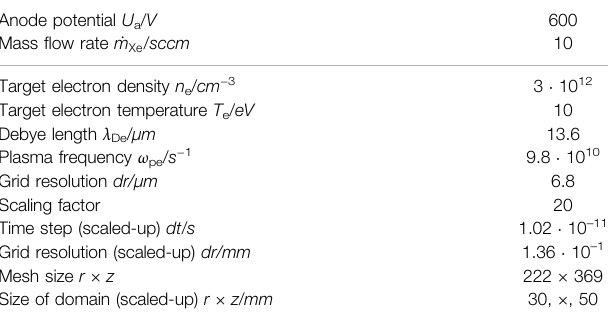
TABLE 1 | Experimental and simulation parameters (below the horizontal line).